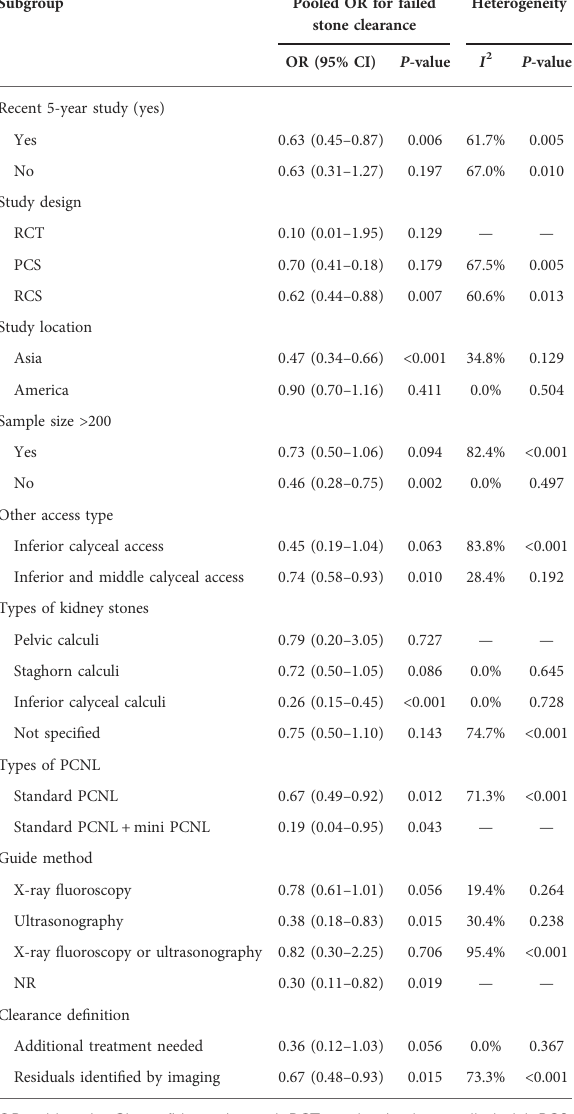
TABLE 3 Subgroup analyses of failed stone clearance. TABLE 4 Subgroup analyses of complication.